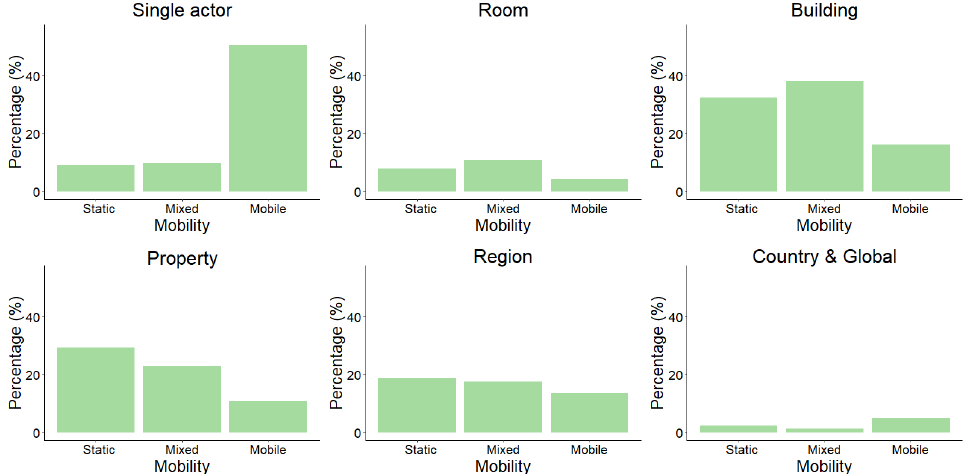
Figure 23. Deployment distribution between node mobility and deployment scale.